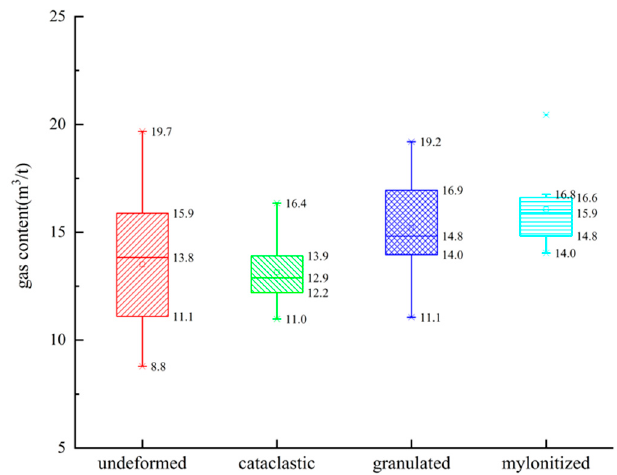
ff erent TDC from data listed in Table